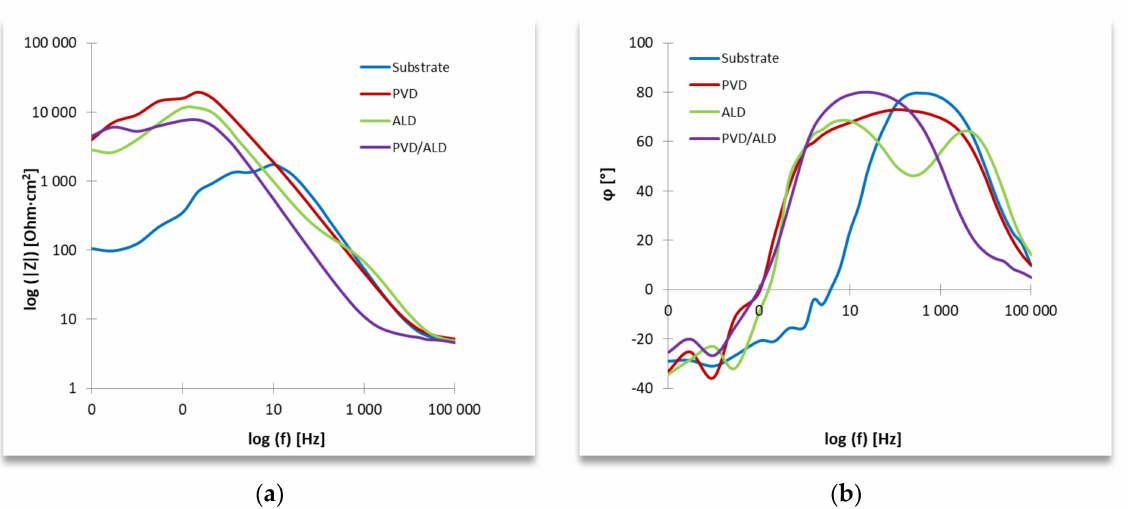
Figure 8. Impedance spectrum of the tested materials (for designated stationary potentials)—Bode representation: ( a ) impedance as a function of frequency and ( b ) phase angle as a function of